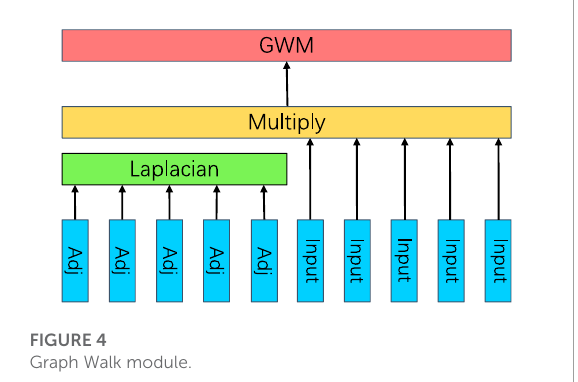
FIGURE 4 Graph Walk